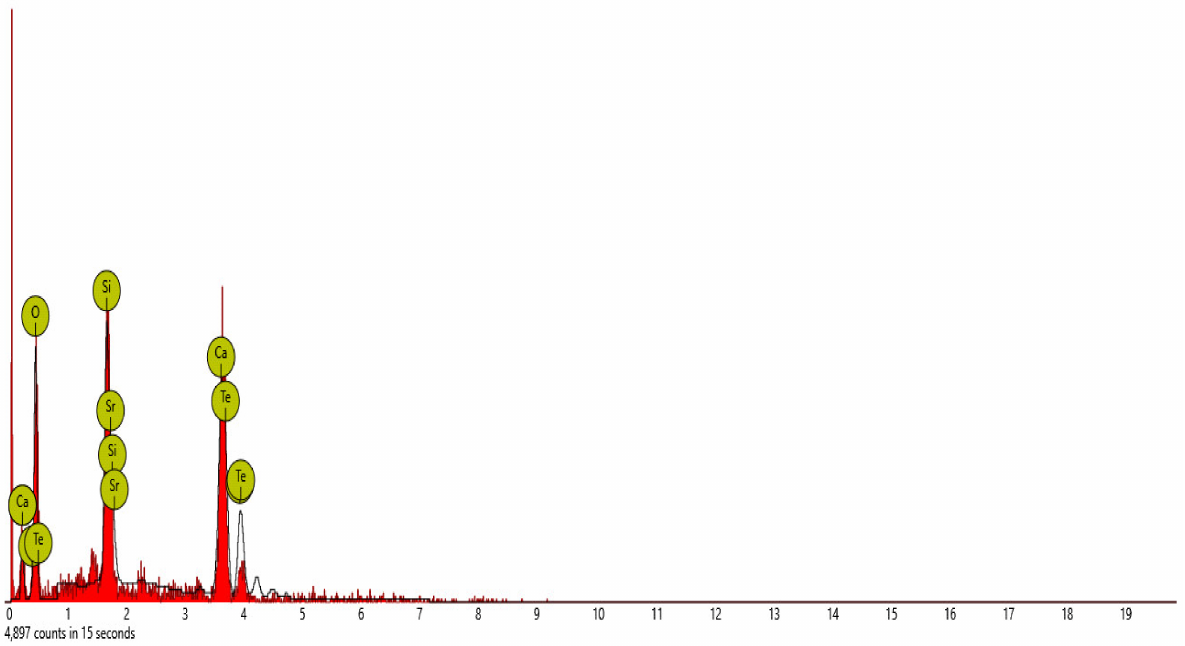
Figure 17. Graphical charts illustrating the atomic quantifications and the weight of the elements discovered from the EDS spectra of pervious concrete sample Y 3